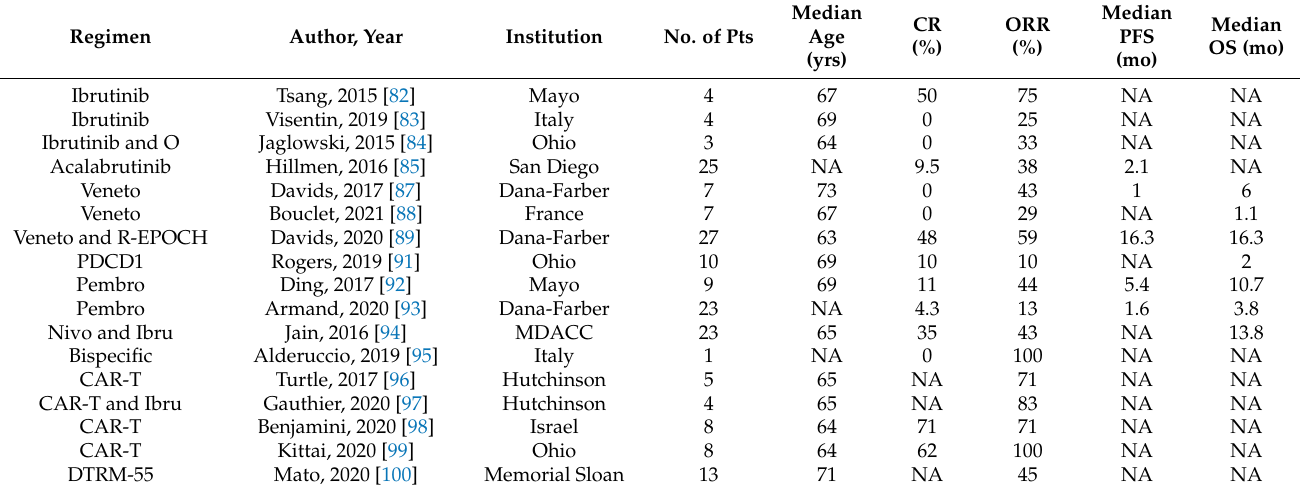
Table 3. Novel agent evaluated for the treatment of